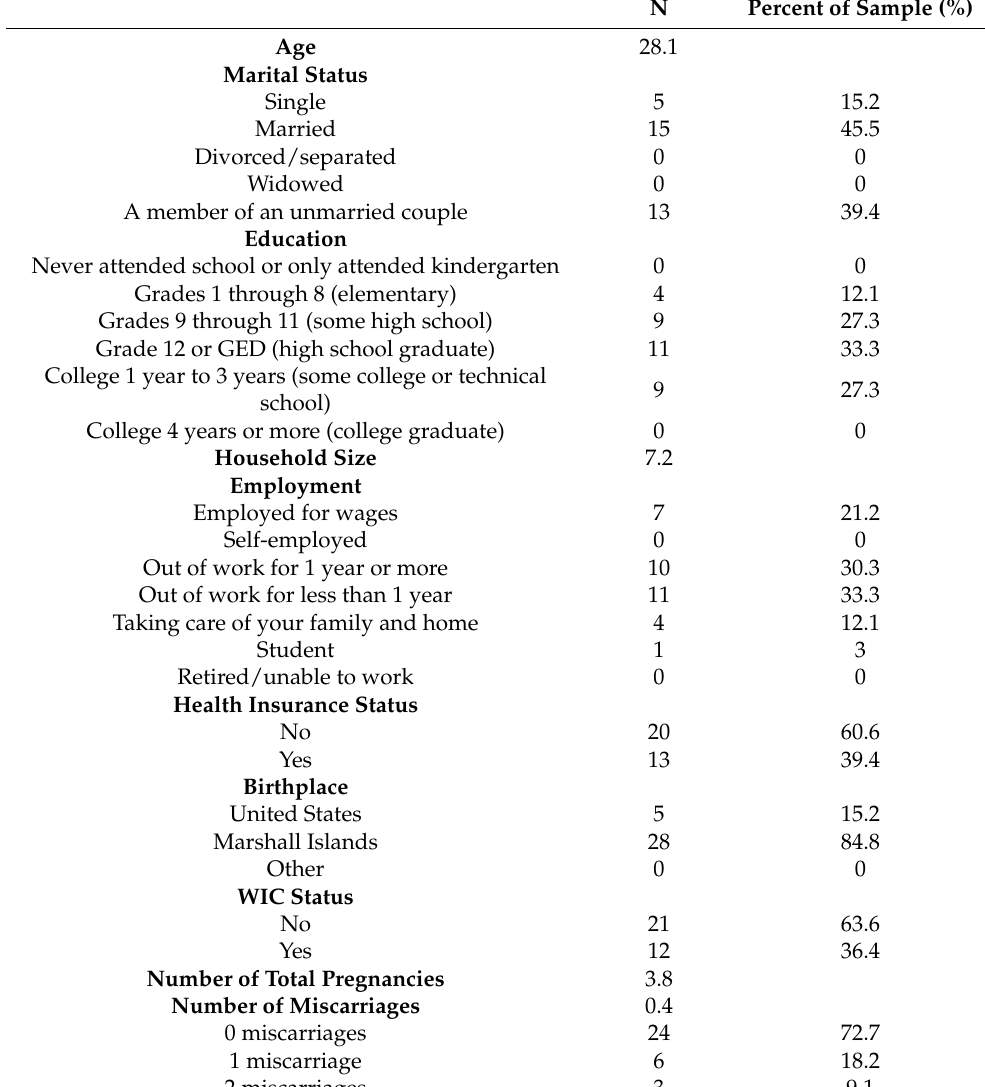
Table 1. Participant demographics (N =